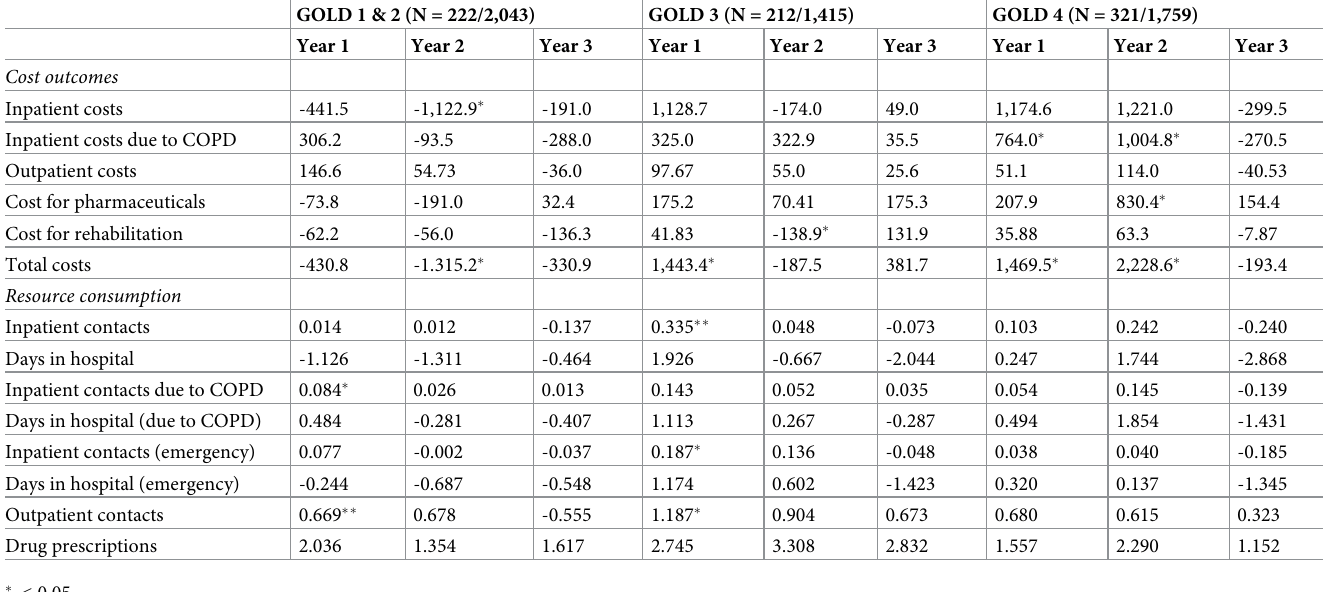
Table 3. Subgroup analysis per GOLD